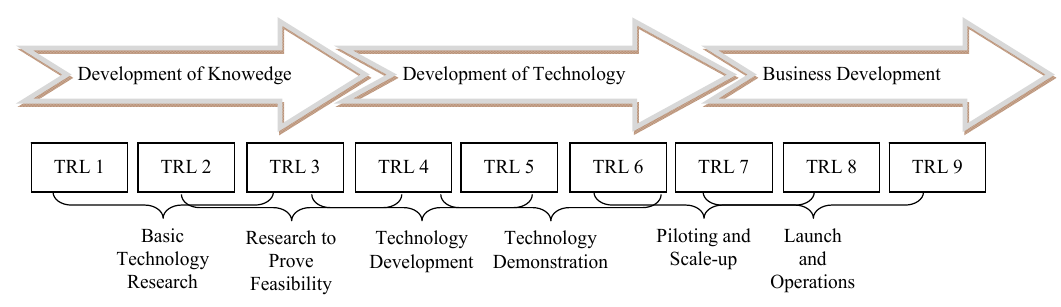
Figure 2. Technology Readiness Level, own illustration based on [28].